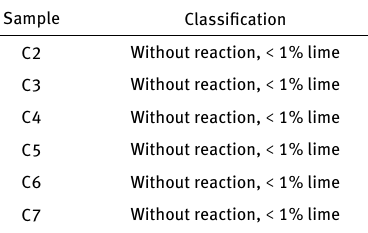
Table 8: Acid test